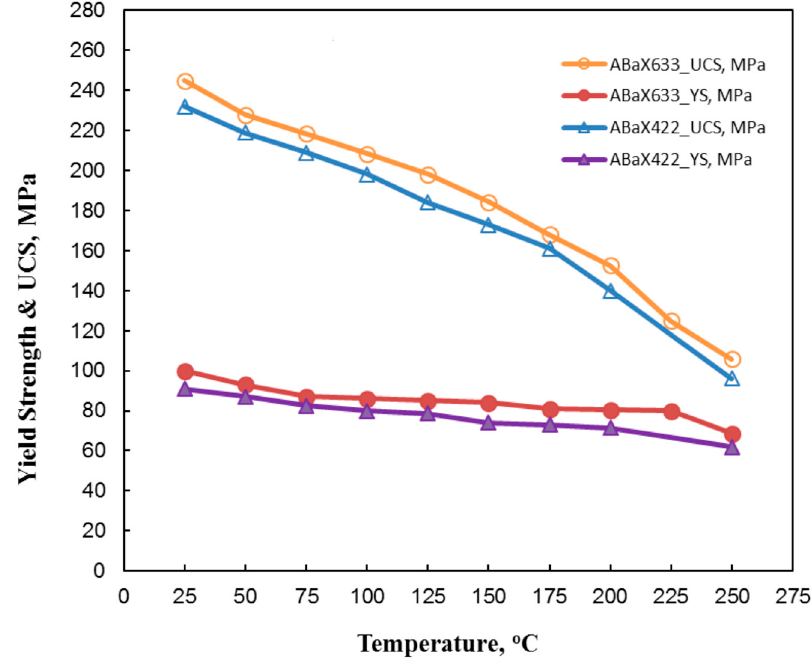
Figure 3. Ultimate compressive strength (UCS) and yield strength (YS) of ABaX633 and ABaX422 alloys.